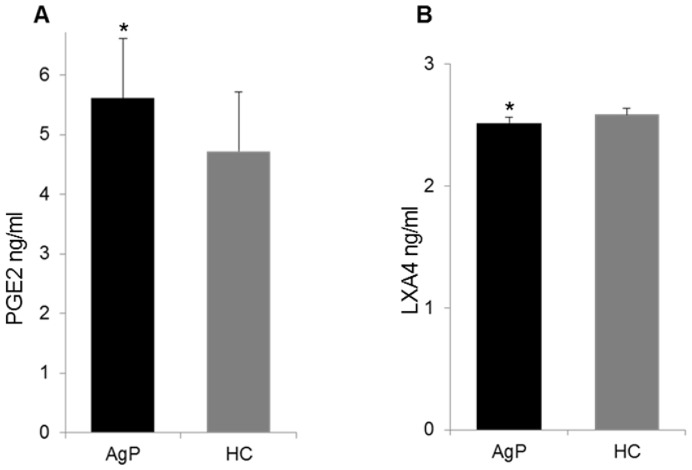
ELISA analysis.Concentration (ng/ml) of PGE2 and LXA4 as determined by ELISA in gingival crevicular fluid (GCF) samples of aggressive periodontitis (AgP) patients (black bar) and healthy controls (HC) (grey bar) * = P<0.05 by use of Mann-Whitney test.